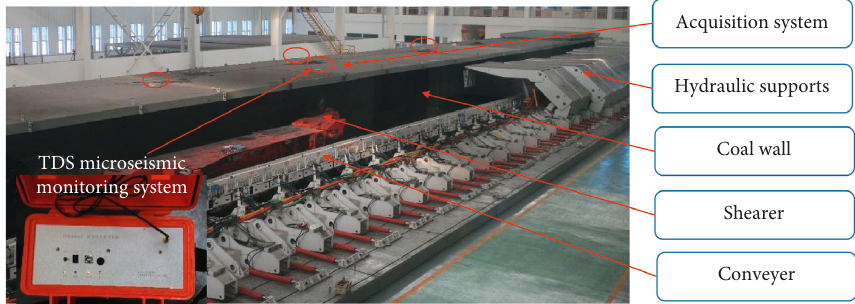
Figure 2: Comprehensive excavating equipment testing lab and acquisition system.